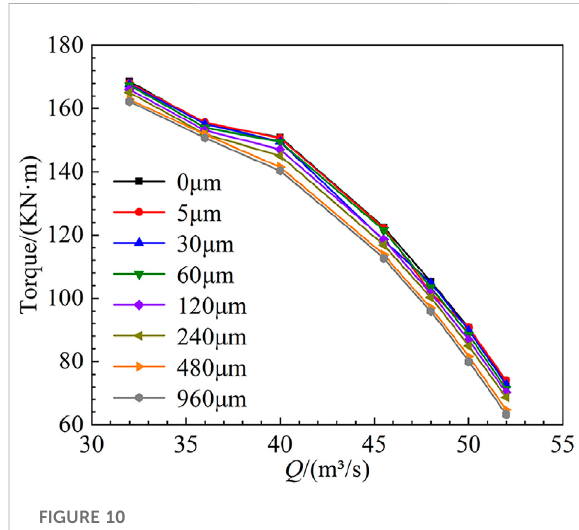
FIGURE 10 Impeller torque of IR pumps with different Ra